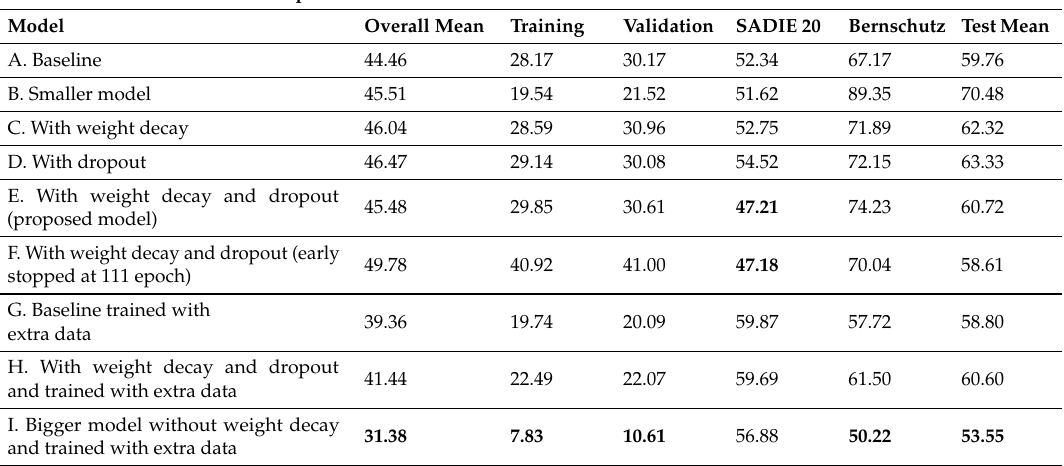
Table 7. Comparison of MSE among different models. This table shows that the bigger model without weight decay and trained with extra data (Model I) performed the best with the Bernschutz test data, and also generalised better with different measurement methods (in bold). However, for the SADIE II Subject 20 test data, the proposed model (Model E) and the early stopped proposed model (Model F) performed the best among all models (in